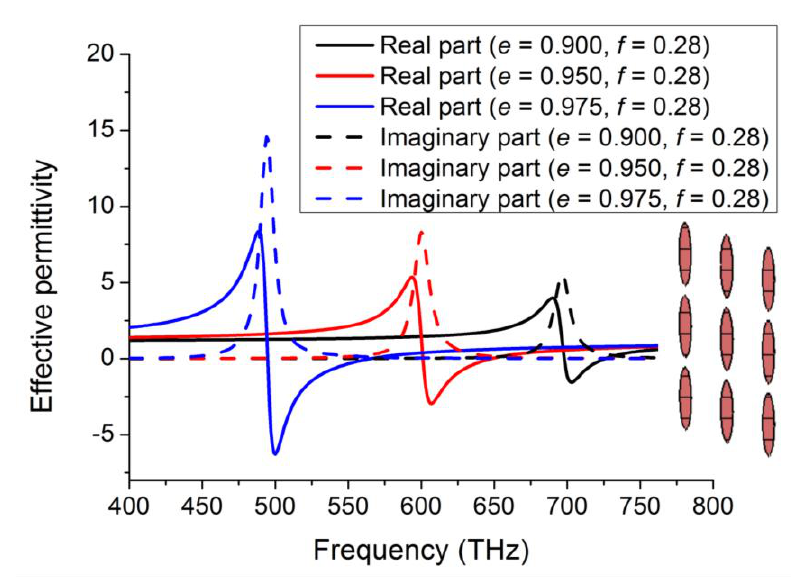
Figure 3. Effective relative permittivity of an array of silver ellipsoidal NPs for different values of the NP eccentricity e